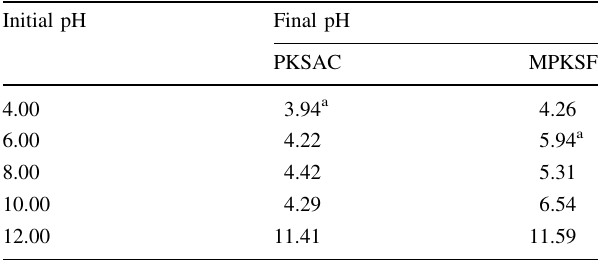
Table 2 Initial and final pH value of PKSAC and MPKSF reaction solutions Initial